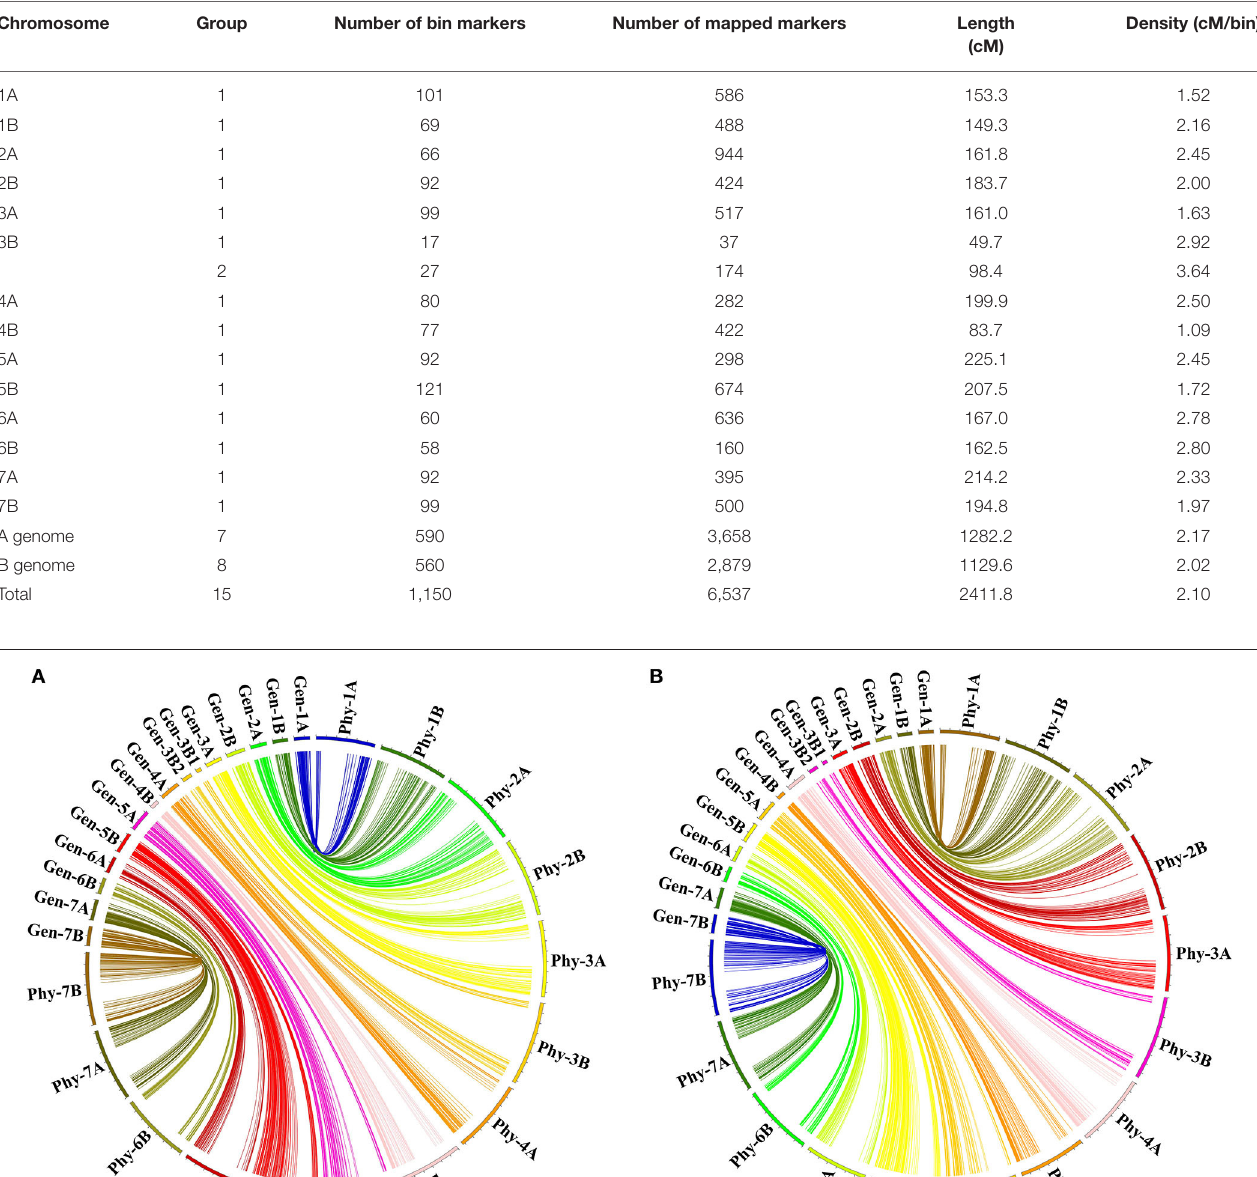
TABLE 1 | Information of single-nucleotide polymorphism (SNP) markers in the constructed genetic map. Chromosome Group